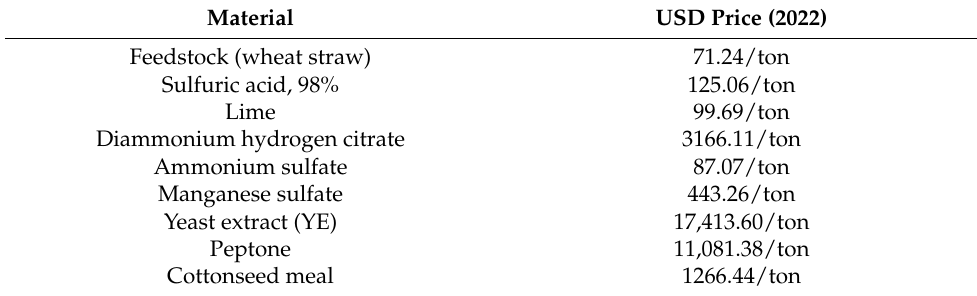
Table 5. The prices of the materials used in techno-economic evaluations.